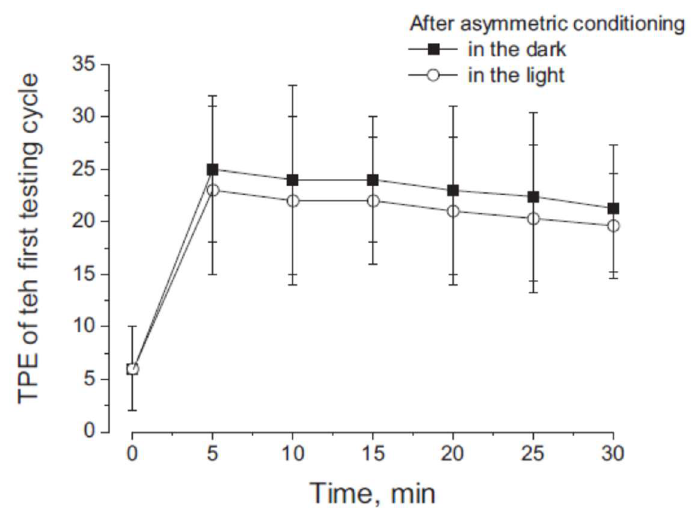
Figure 5. Time course TPE in response to the first cycle of testing asymmetric rotation delivered at different intervals from the conditioning procedure (time = 0). Data are the mean and SD of TPE.